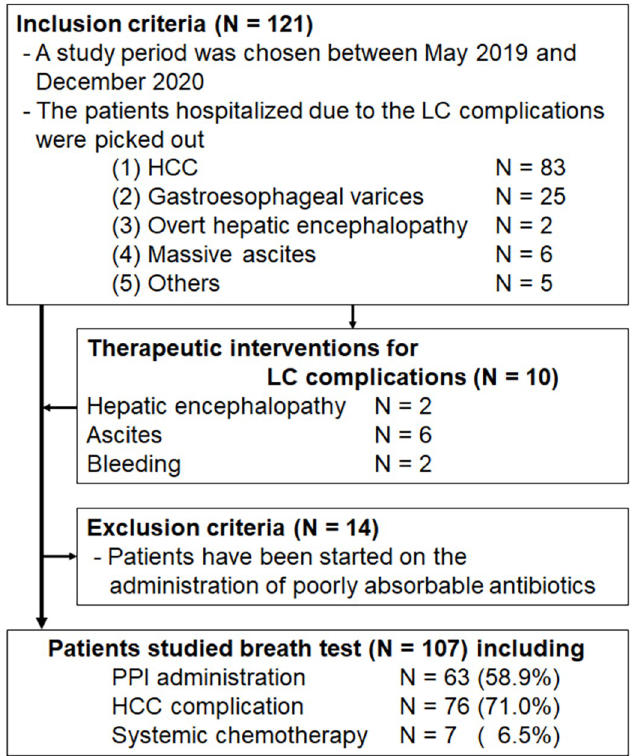
Fig 1. Patient selection procedure and study procedure. LC, liver cirrhosis; HCC, hepatocellular carcinoma; PPI, proton pump inhibitor.